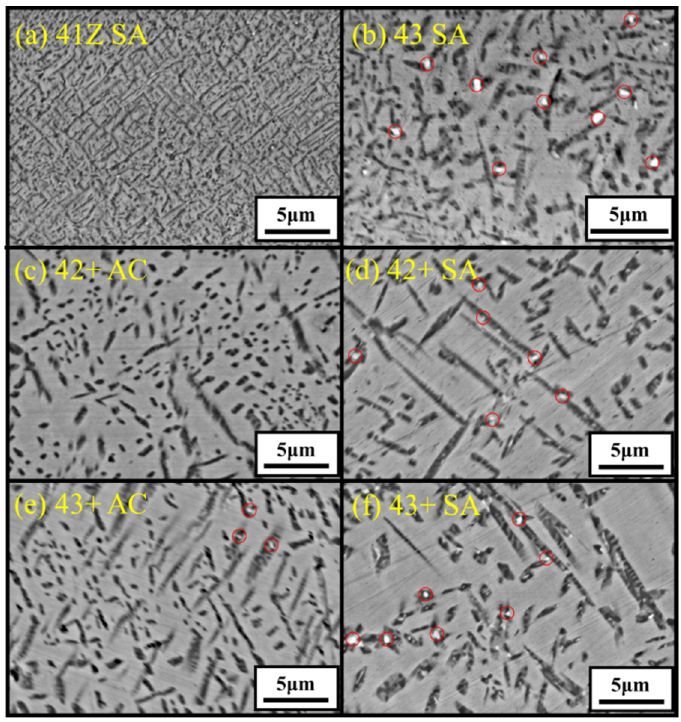
Figure 9. SEM-BSE images showing the microstructure near (3 mm away from) the fracture region for alloys ( a ) 41Z SA, ( b ) 43 SA, ( c ) 42+ AC, ( d ) 42+ SA, ( e ) 43+ AC, and ( f ) 43+ SA after the creep test in air at 750 °C and 150 MPa. Laves phases are encircled.